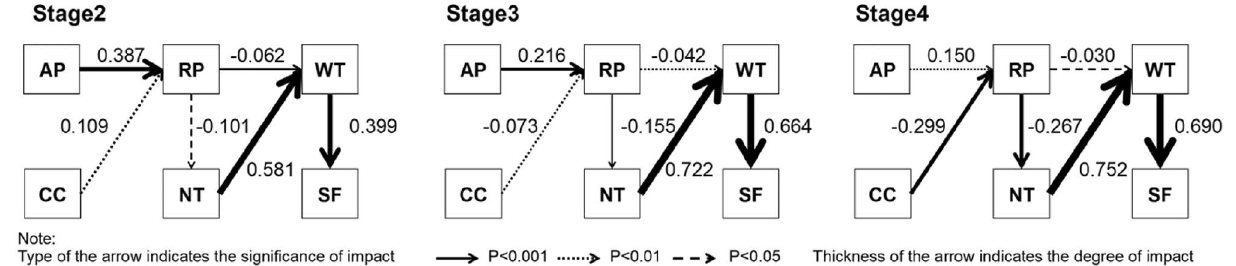
Figure 4. Path analysis of impact paths on self-reported frequency to travel during stage2 to stage4. Confirmatory factor analysis and Goodness-of-fit statistics in Table